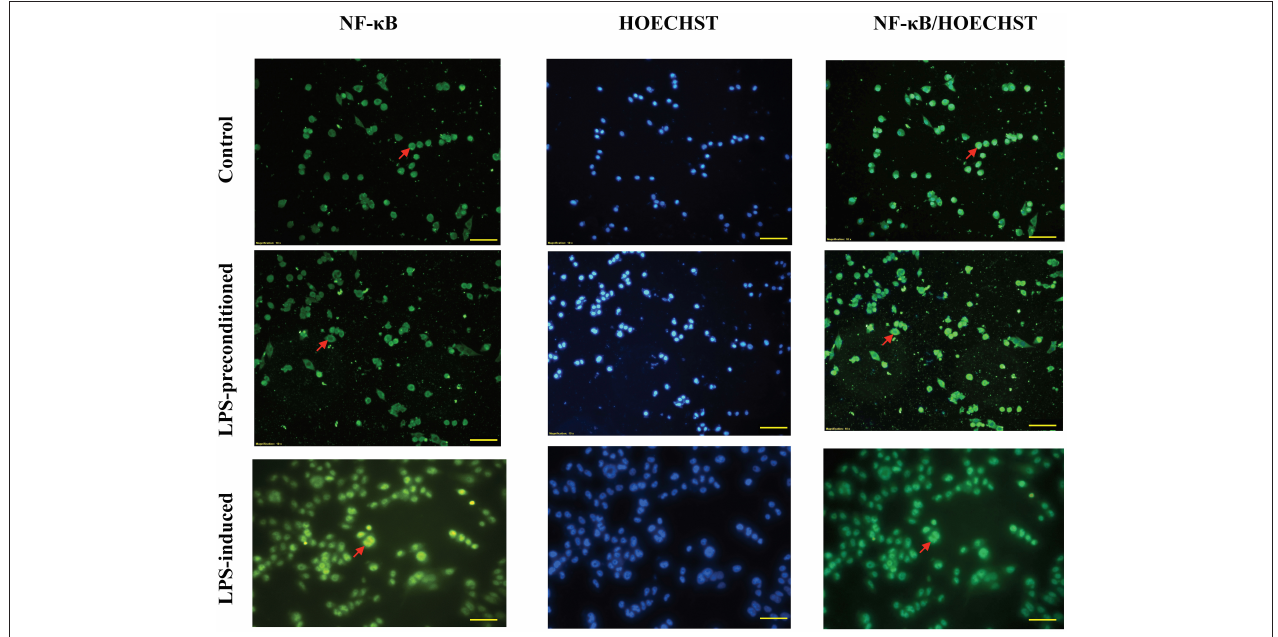
FIGURE 13 | Immunofluorescence analysis of NF- κ B activation. The nuclear translocation was determined by the blue fluorescence (Hoechst staining) and the NF- κ B/p65 subunit by its green fluorescence. Representative fluorescence images from inverted fluorescence microscope. Field of views for each time point from three independent experiments. The translocation of NF- κ B/p65 from the cytoplasm into the nucleus indicated the activation of the transcription factor. Pictomicrographs were taken with original magnification (20 × ); the scale bar represents 100 µ